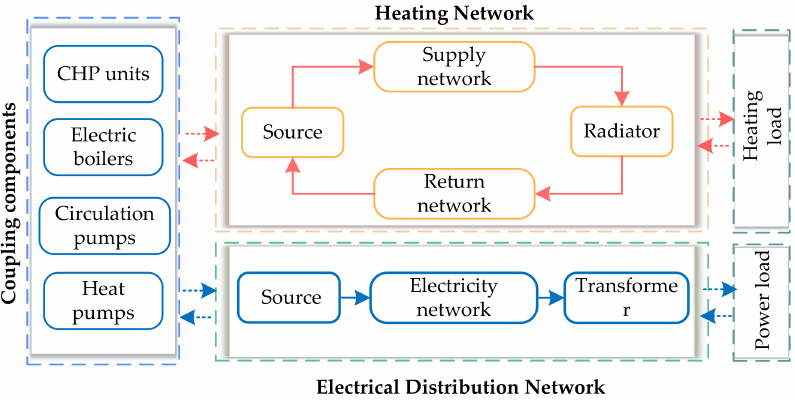
Figure 1. Schematic illustrating the structure of an integrated electrical and heating network